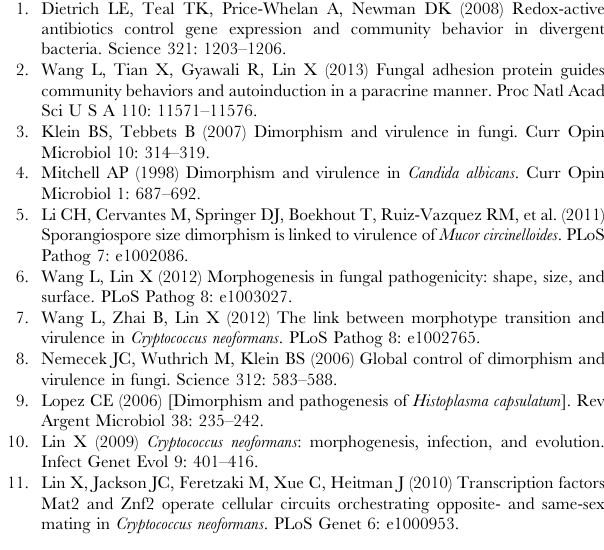
Figure S6 Pum1 orchestrates filamentation and sporu- lation in the clinical isolate H99 during bisexual mating. (A) Deletion of PUM1 impaired filamentation and abolished sporulation during bisexual mating in the H99 background. (B) Pum1 has a minor role in controlling invasive growth but is required for hyphal extension. Table S1 Genes differentially expressed in response to the ZNF2 overexpression under the mating-suppressing condition. Table S2 Genes differentially expressed in response to the PUM1 overexpression under the mating-inducing condition. Table S3 Strains used in this study. Table S4 Primers used in this